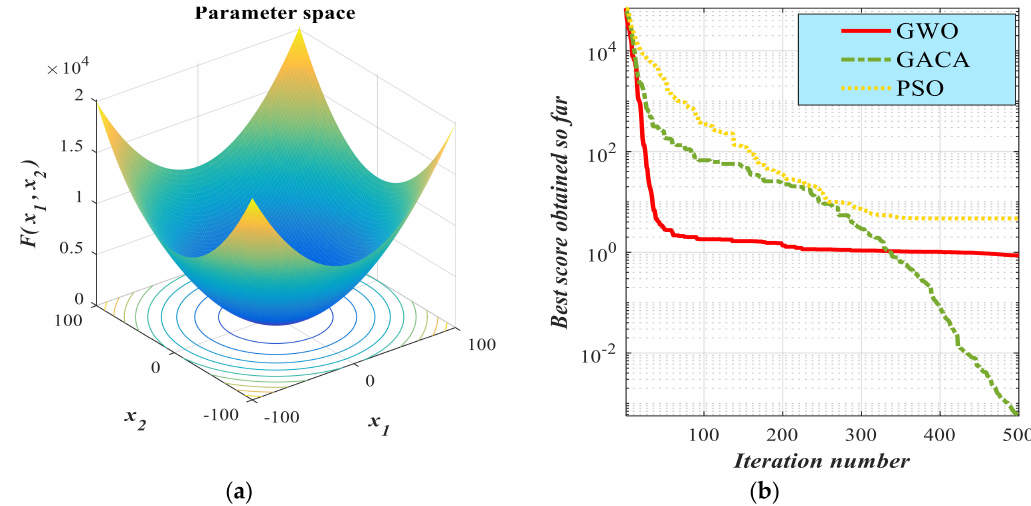
Figure 4. ( a ) The 3D surface plot of the tested function in the parameter space: Y = sum ( ans (( x + 0.5 )) ∧ 2 ) , x 1 , x 2 ∈ [ − 100,100 ] , step = 2; ( b ) the calculated convergence curve through 500 iterations of the grey wolf optimization (GWO), genetic ant colony algorithm (GACA), and particle swarm optimization (PSO) method.